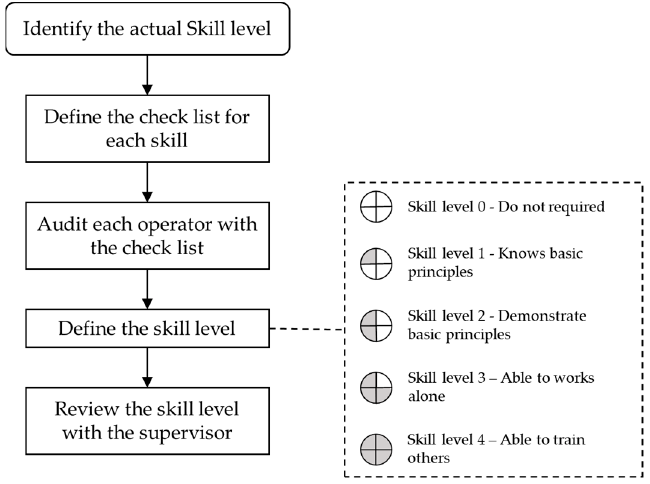
Figure 7. Skill level identification [Source: inspired by the chapter “Skill management” (pages 113–119) in reference [12]].